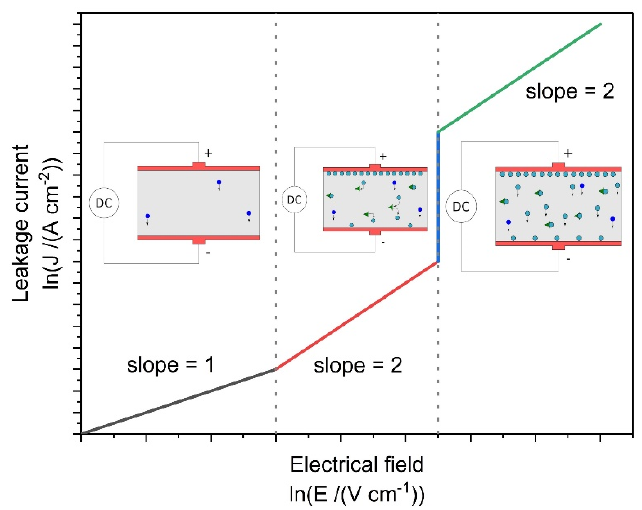
Figure 18. Logarithmic representation of the current–voltage characteristic of a dielectric material according to Space Charge Limited Current mechanism.